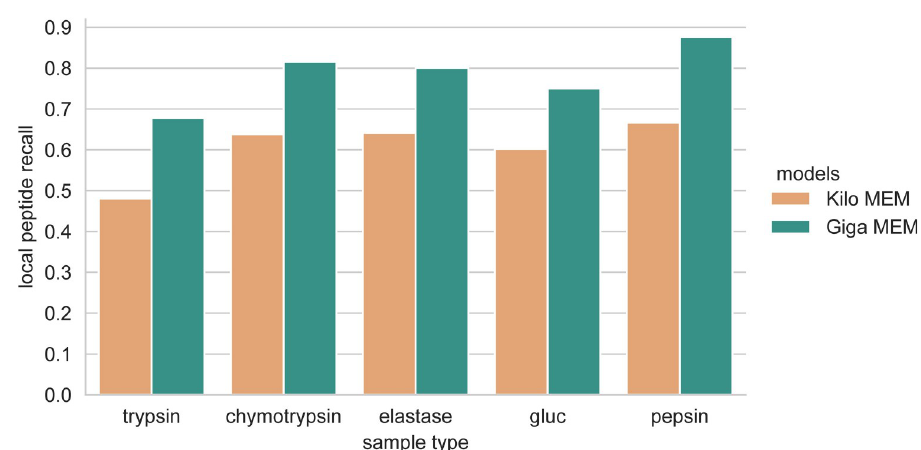
Fig 5. Comparing the performance of the Giga and Kilo MEMs across the Detroit test set’s different sample type components.